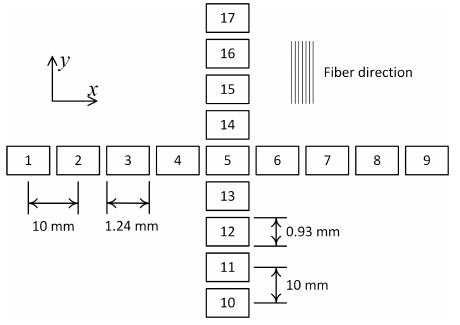
Figure 6. Measurement locations on the composite sheets’